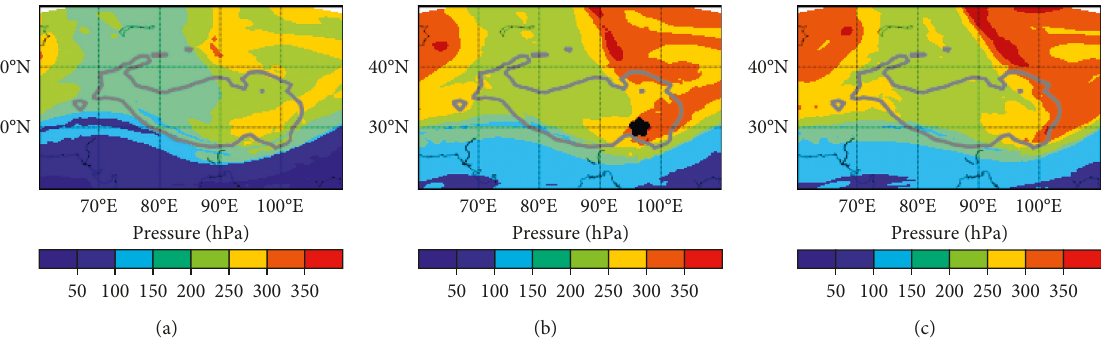
Figure 9: The same as Figure 8, but for the WRF